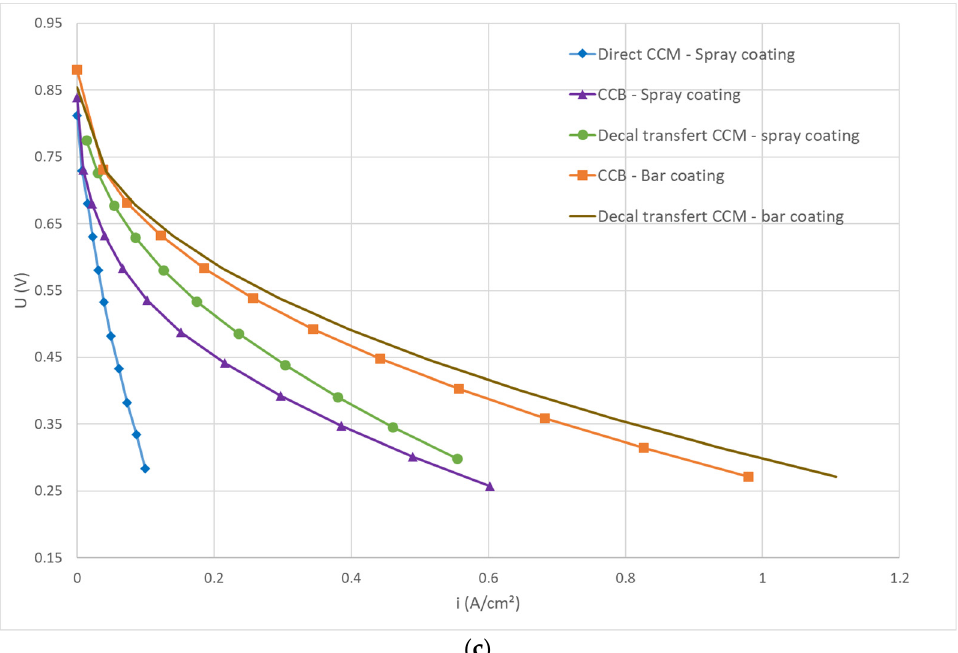
Figure 2. Polarization curves obtained for MEA made by different processes. ( a ) Condition 2 (H 2 /air): 80 ◦ C; 50%RH; 1.5 b; St: 1.2–2; ( b ) Condition 3 (H 2 /air): 80 ◦ C; 50/30%RH; 2.5/2.3 b; St: 1.3/1.5; ( c ) Condition 5 (H 2 /O 2 ): 80 ◦ C; 50%RH; 1.5